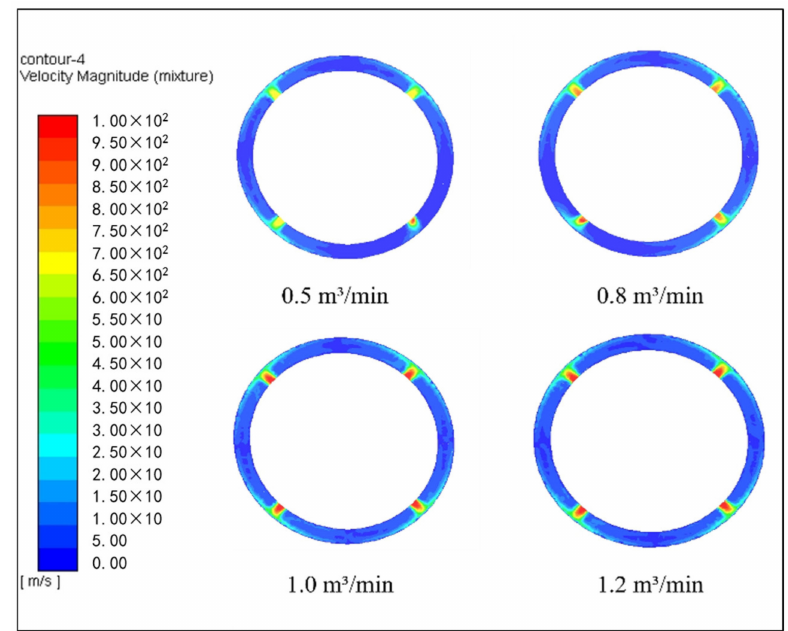
Figure 19. Velocity distribution of rotary jets at different volume flow.